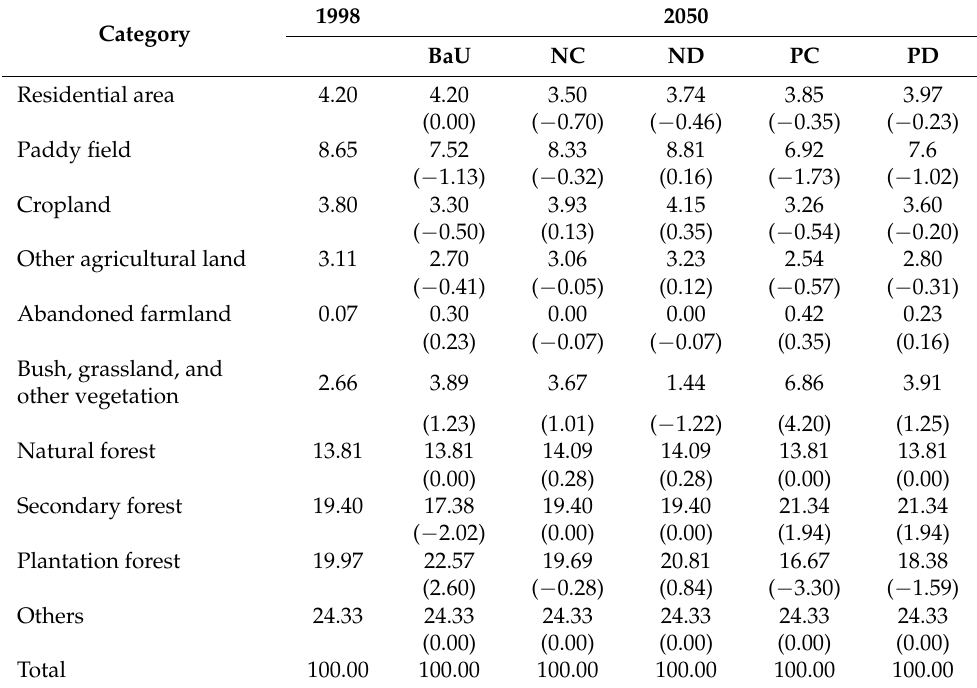
Table 2. The proportions of each land-use category in each